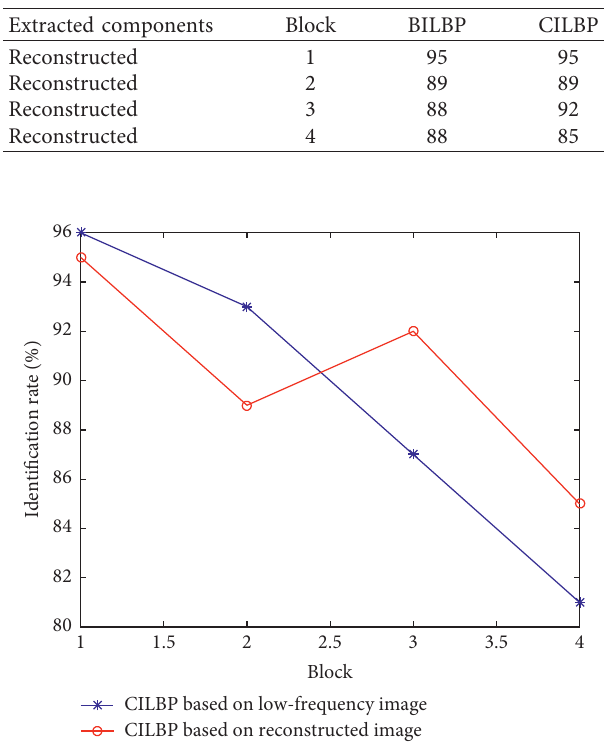
Figure 10: Comparison of CILBP identification rate.